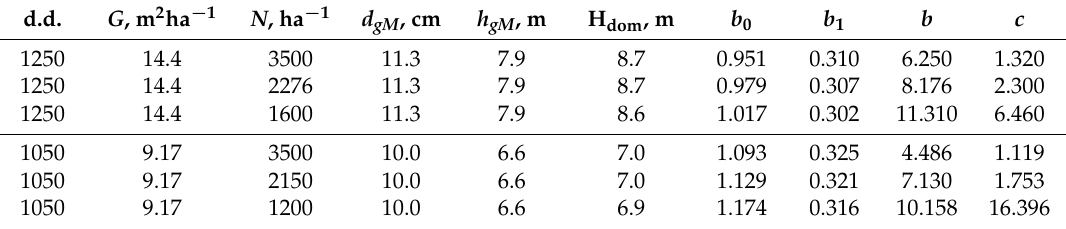
Table A1. Stand characteristics, parameters of the predicted Näslund’s height curve ( b 0 , b 1 ), and recovered parameters of a two-parameter Weibull distribution ( b , c ). The stands represented Myrtillus type (MT) fresh sites in southern (temperature sum 1250 degree days (d.d.)) and central (1050 d.d.) Finland. (For Näslund’s height curve and Weibull distribution, see e.g., [26,27]).